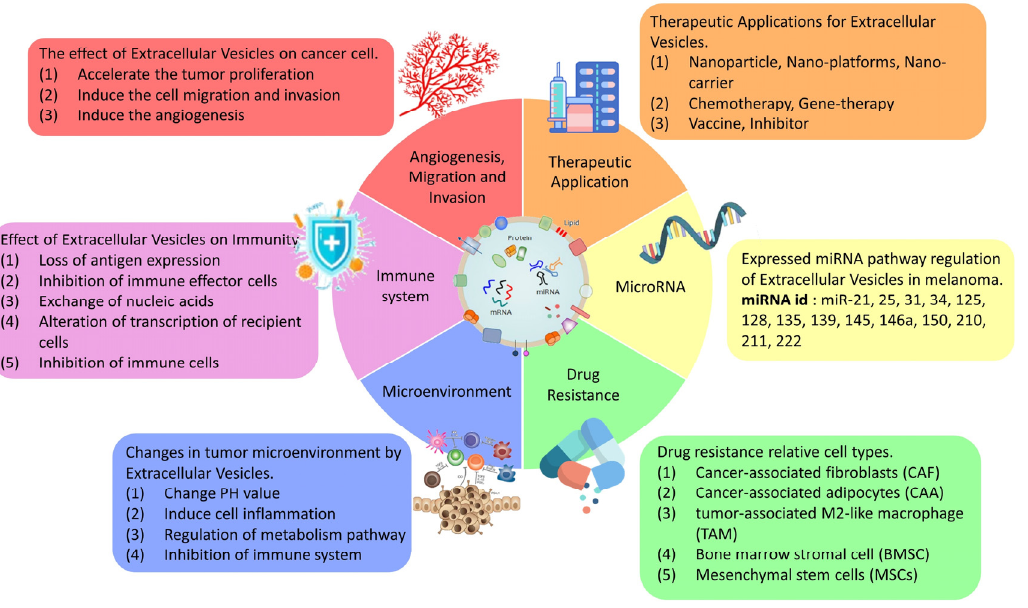
Figure 2. The summary of EV effectiveness in cancer therapeutic treatments.